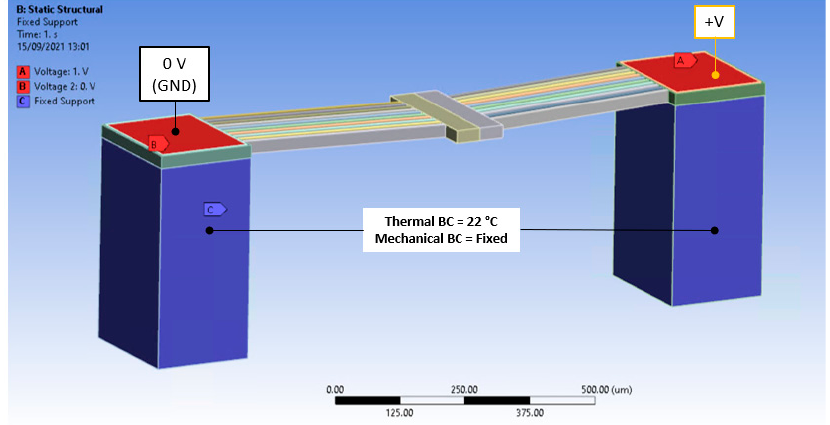
Figure 5. The basis of the thermal-electric model setup within the finite element solver, in this case, ANSYS Mechanical. This setup is applicable to the finite element model of both numerical methodologies presented within this work.